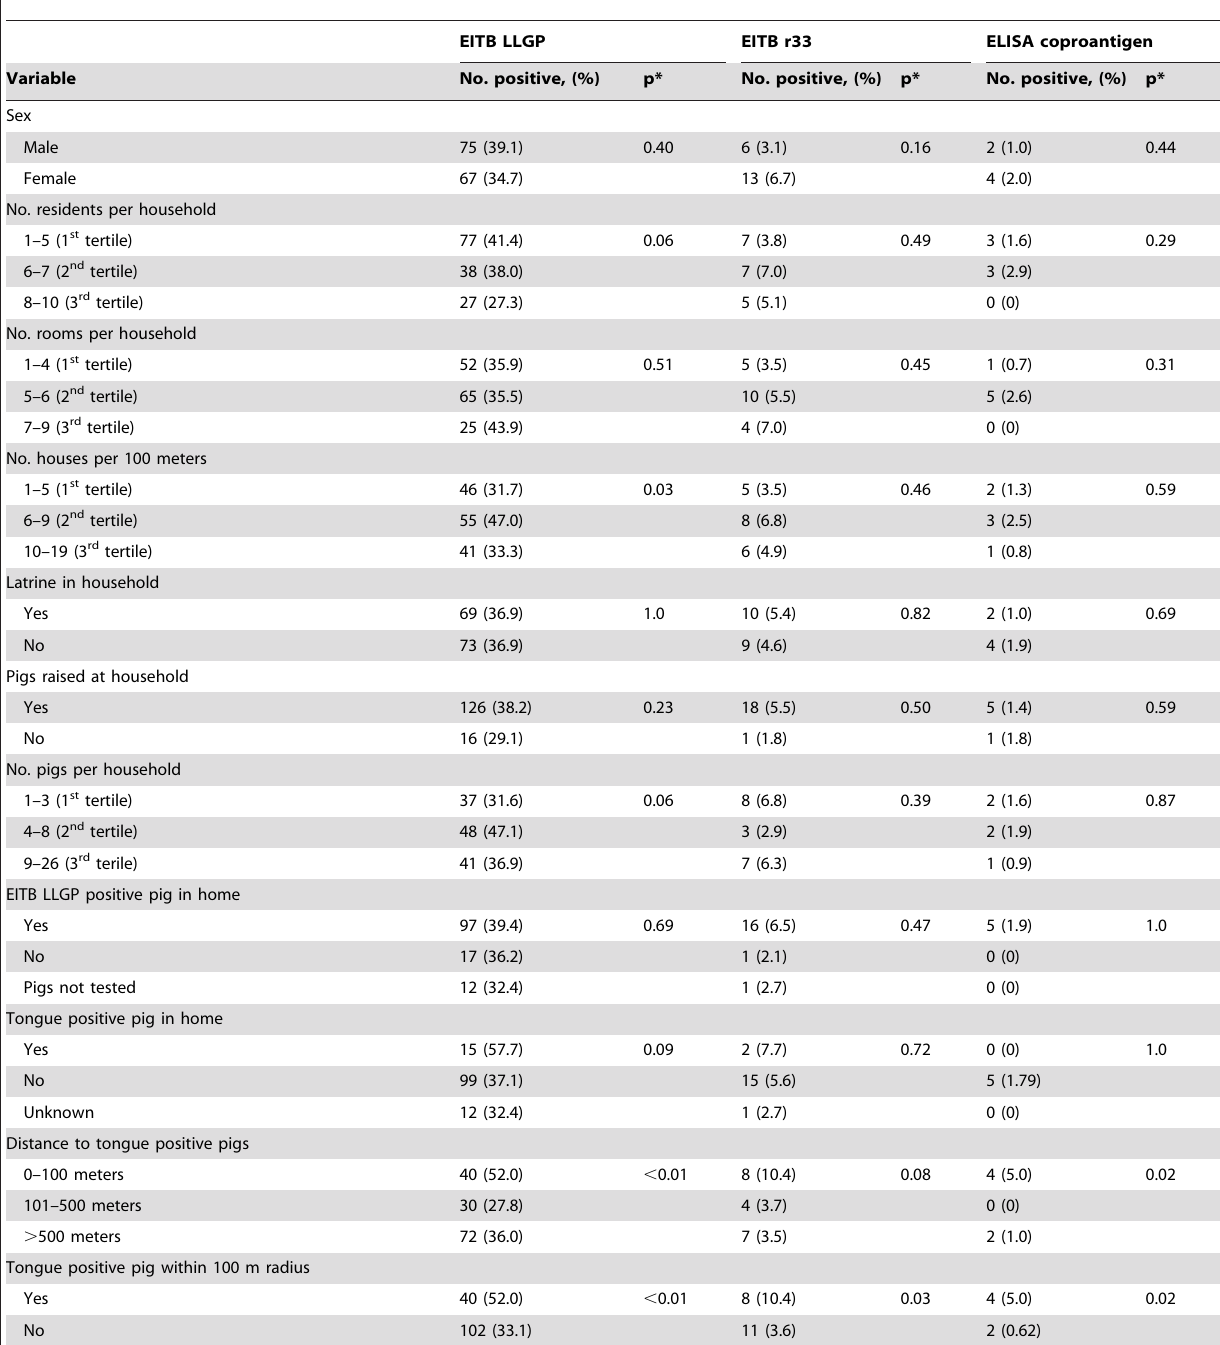
Table 3. Relationship between household characteristics and laboratory results for Taenia solium infection in humans, Rica Playa, Tumbes, Peru.